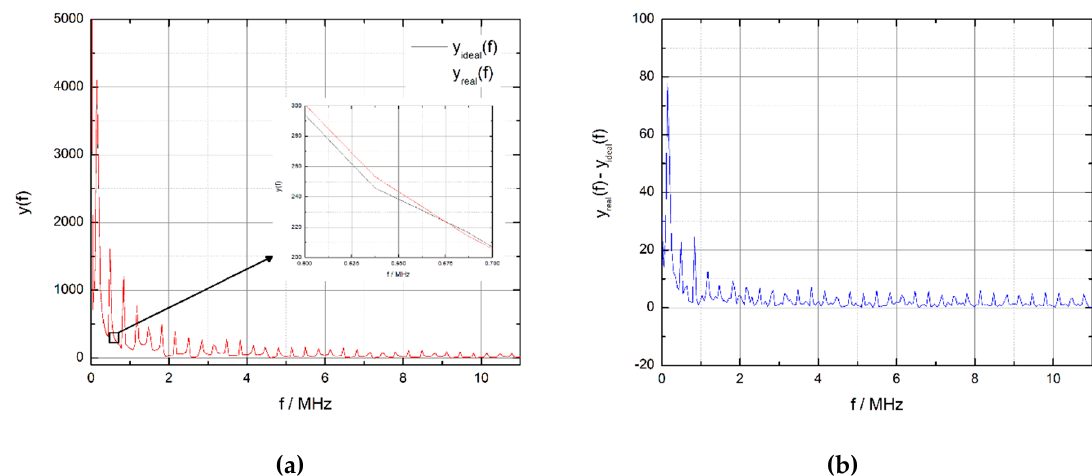
Figure 3. ( a ) Spectrums of real and simulated photodetector signals; ( b ) result of spectrum subtraction. High voltage pulse frequency at 180 kHz.